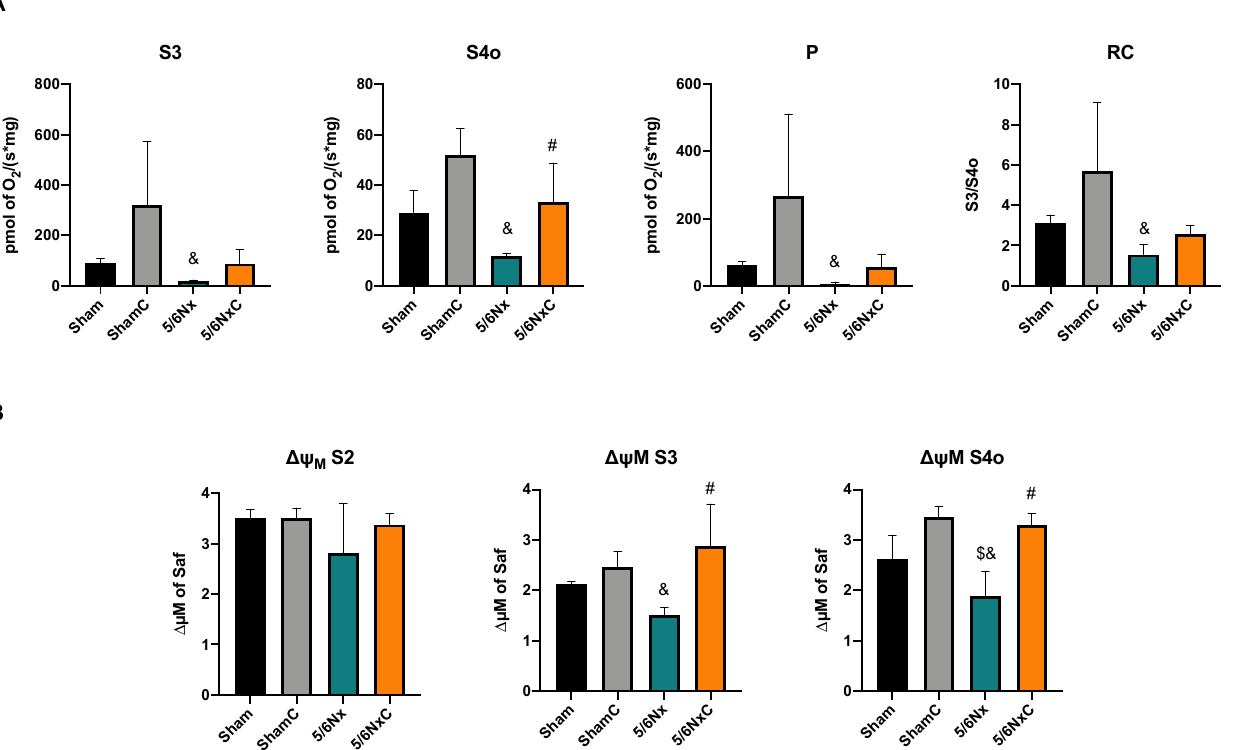
Figure 5. Kidney mitochondrial β -oxidation in the four groups of rats studied: Sham, Sham + cur- cumin (ShamC), five-sixths nephrectomy (5/6Nx), and 5/6Nx + curcumin (5/6NxC). ( A ) Respiration and ( B ) Membrane potential. S3 = State 3, S4o = State 4 induced by oligomycin, P = Oxidative phosphorylation associated respiration, RC = Respiratory control, ∆Ψ m = Changes in mitochondrial membrane potential, Safranin (Saf). One-way analysis of variance (ANOVA), post hoc Fisher ´ s Least significant difference (LSD). Mean ± SD, n = 3. $ p < 0.05 vs. Sham, & p < 0.05 vs. ShamC, # p < 0.05 vs. 5/6Nx.